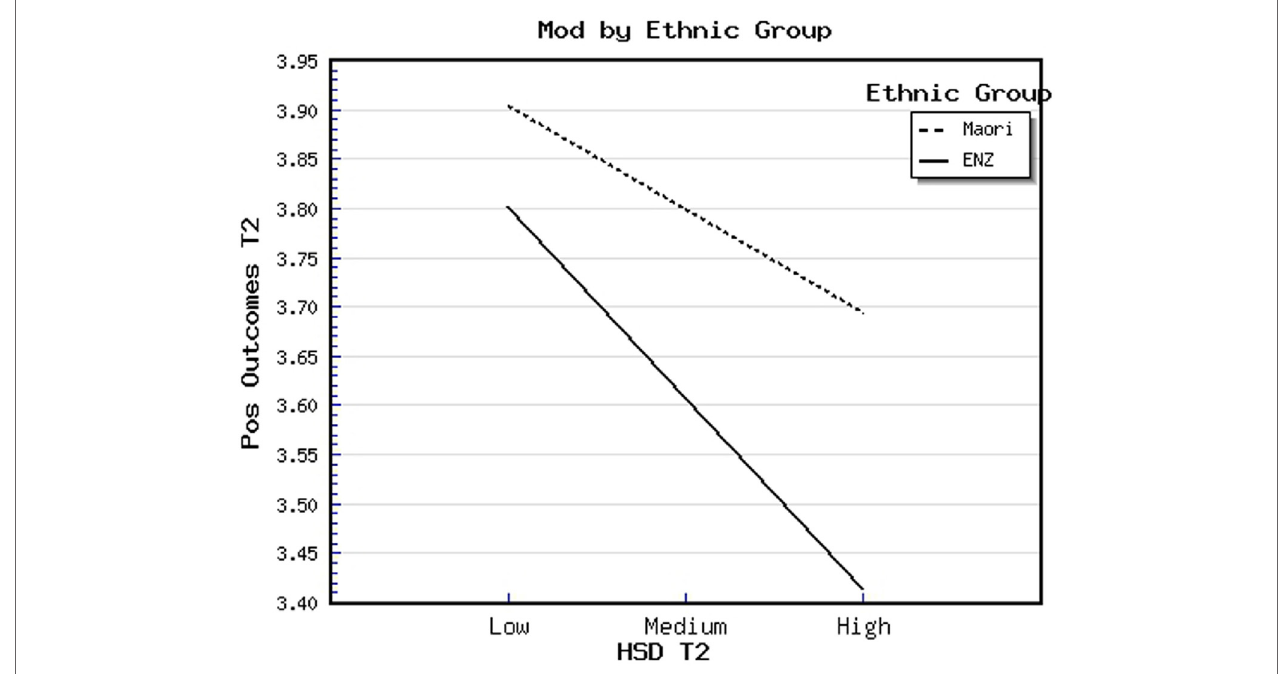
FigUre 2 | The association between home–school dissonance (HSD) and positive outcomes at Time 2 moderated by ethnic group